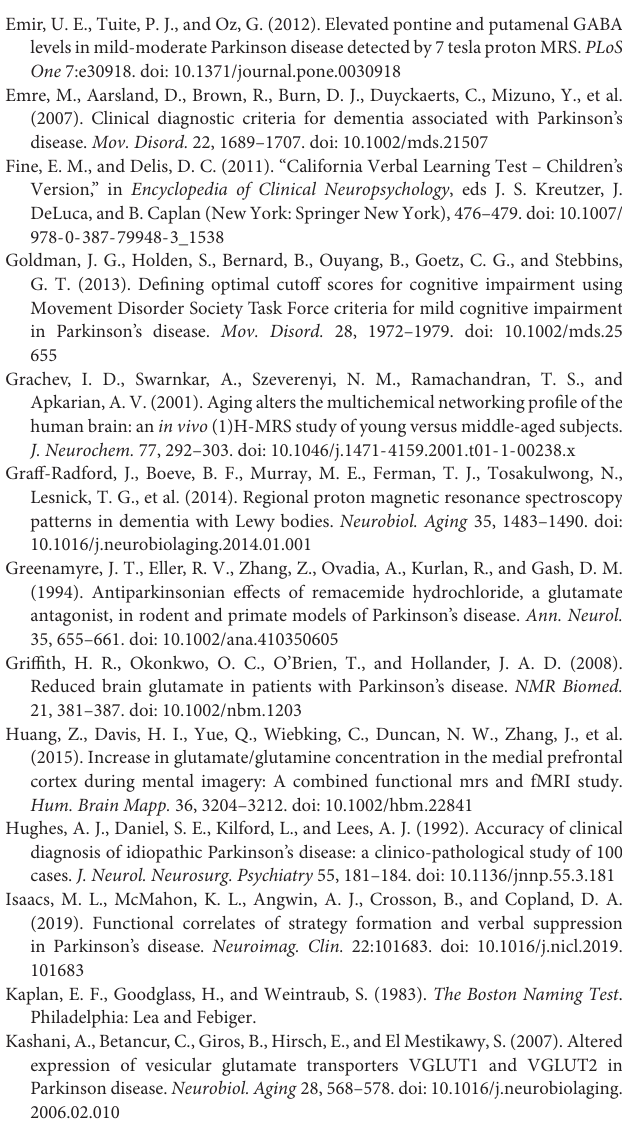
three comparisons, the p value has to be below 0.05/1 = 0.01 for an effect to be significant at the 0.05 level. For these data, all p values are far below that, and therefore all pairwise differences are not significant. Supplementary Table 4 | Corrected metabolite measures for the presence of CSF by cognitive classification. Means, SDs and f -values calculated using SPSS; Post hoc group comparisons using Bonferroni correction for each corrected metabolite level; bold text indicates statistically significant values at p < 0.05. Glu, Supplementary Table 5 | Pearson product-moment correlation coefficient related to metabolite measures. Means, SDs, R 2 -values and p -values calculated using SPSS; ∗ indicates statistically significant values at p < 0.05. JLO, Judgment of Line Orientation; B-H, Benjamini-Hochberg. False Discovery Rate correction using the B-H method was used to calculate Critical Values for the Glu/Cre linear regression analyses. P -values over the B-H Critical Values are interpreted as statistically